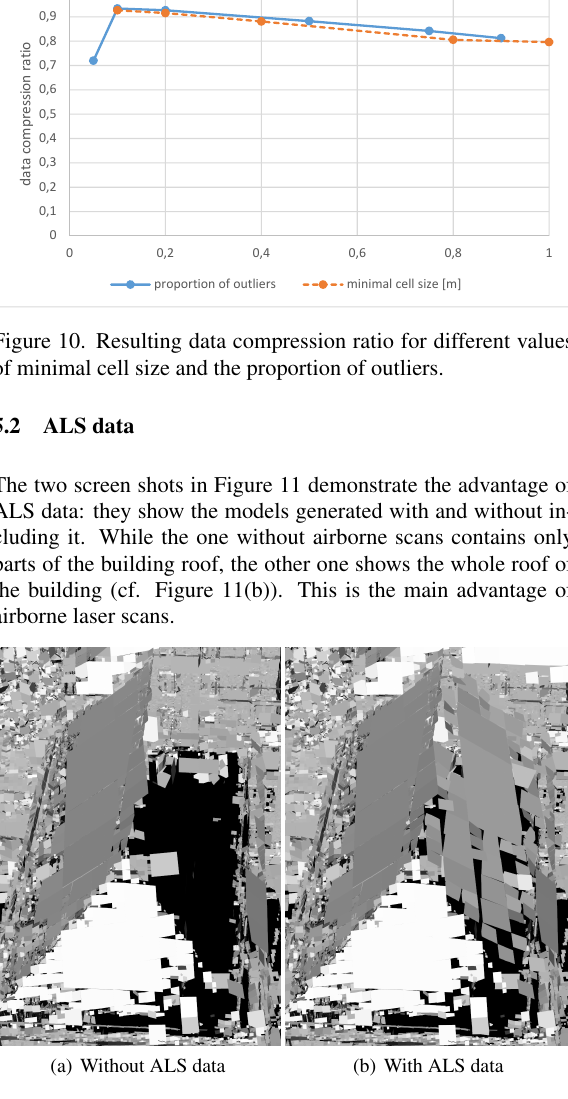
Figure 11. Impact of ALS data on the generated